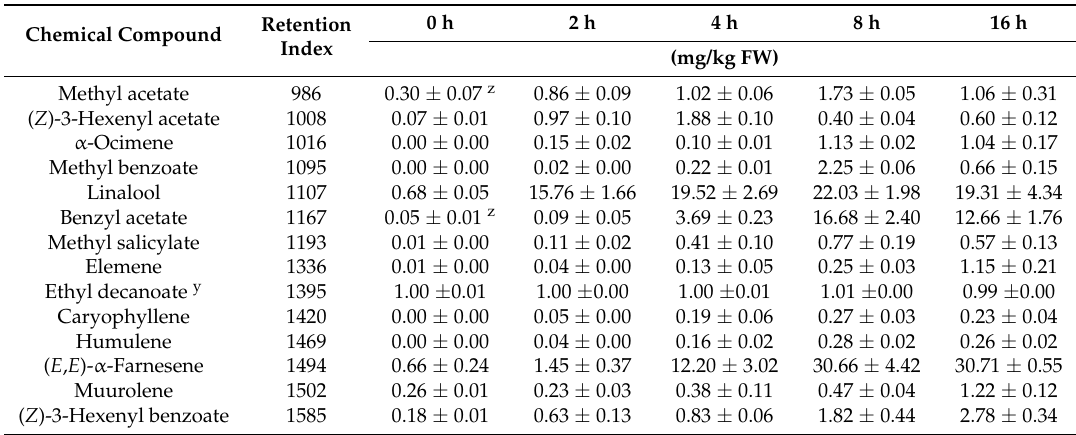
Table 2. Volatile compounds emitted from excised flowers of Jasminum sambac ‘Bifoliatum’ from the time of excision to 16 h thereafter at a temperature of 35 ◦